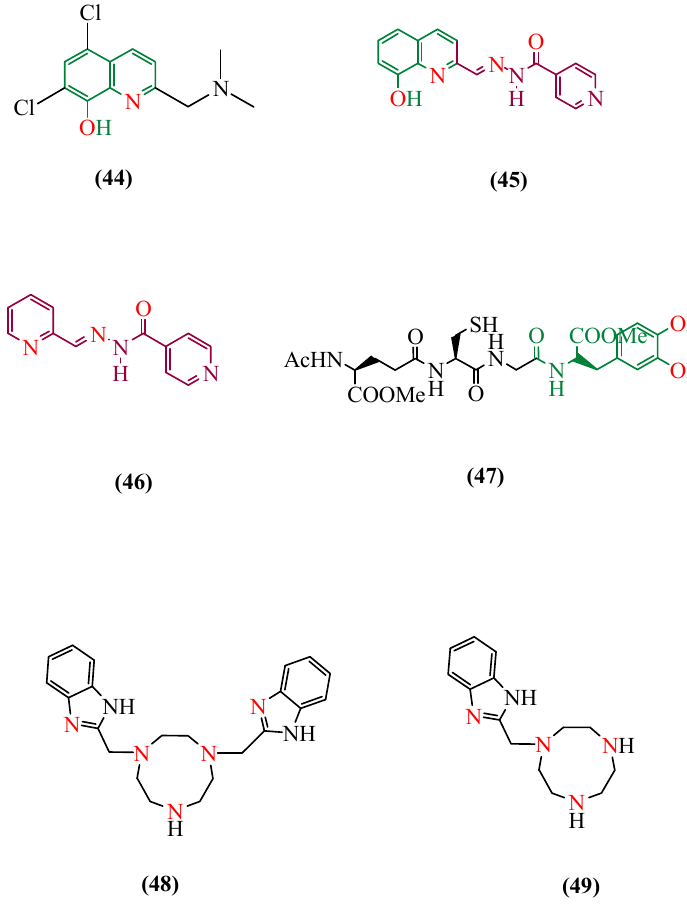
Figure 12. Chemical structures of metal protein attenuating compounds PBT2, ( 44 ), 5,7-Dichloro- 2-dimethylaminomethyl-quinolin-8-ol; INHQ ( 45 ), 8-hydroxyquinoline-2-carboxaldehyde isonicotinoyl hydrazone; HPCH ( 46 ), pyridine-2-carboxaldehyde isonicotinoyl hydrazone; GSH-LD ( 47 ), 2-Acetylamino- 4-[1-({[2-(3,4-dihydroxy-phenyl)-1-methoxycarbonyl-ethylcarbamoyl]-methyl}-carbamoyl)-2-mercapto- ethylcarbamoyl]-butyricacidmethylester;1-BYT( 48 ),1-(benzimidazole-2-ylmethyl)-1,4,7-triazacyclononane and 1,4-BYT ( 49 ),